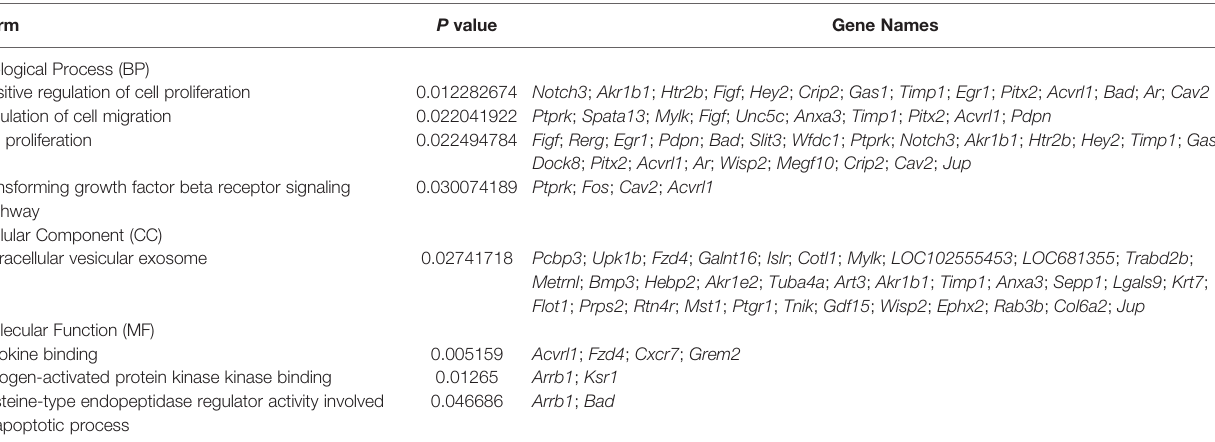
TABLE 3 | The main GO terms involved in activation of ISCs.